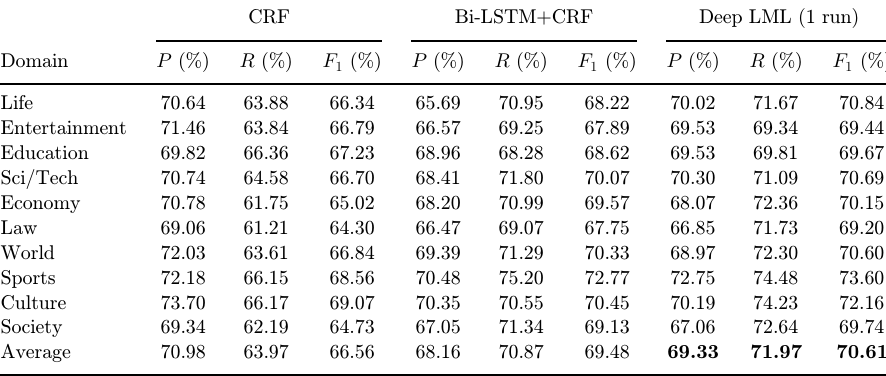
Table 7. In-domain